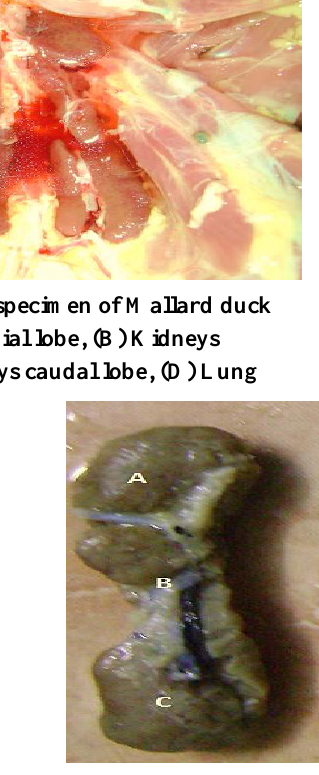
Figure, 5: left and right kidneys after removal from cadavers’ shows :(A) Cranial lobe , (B) Middle lob, (C) Caudal lobe.